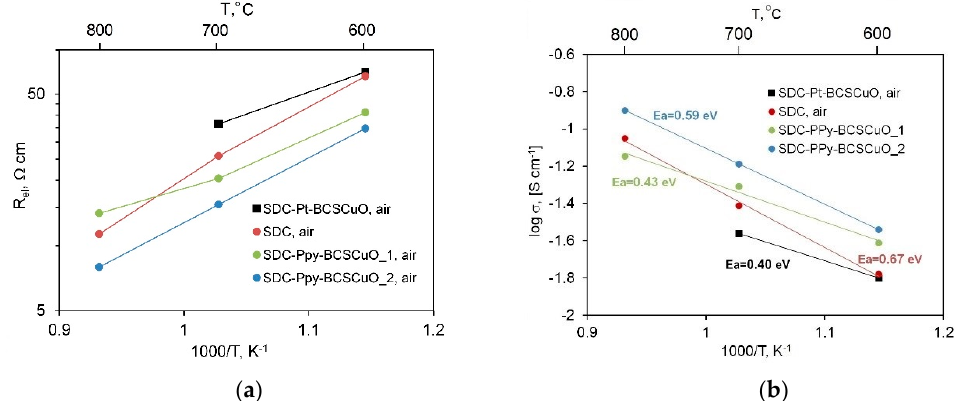
Figure 10. Electrical properties of the SDC samples without/with BCSCuO barrier layers, measured in air by the impedance spectroscopy method: ( a ) Specific ohmic resistance of the samples derived from the spectra; ( b ) Calculated values of the electrolyte substrate conductivity and activation energy.